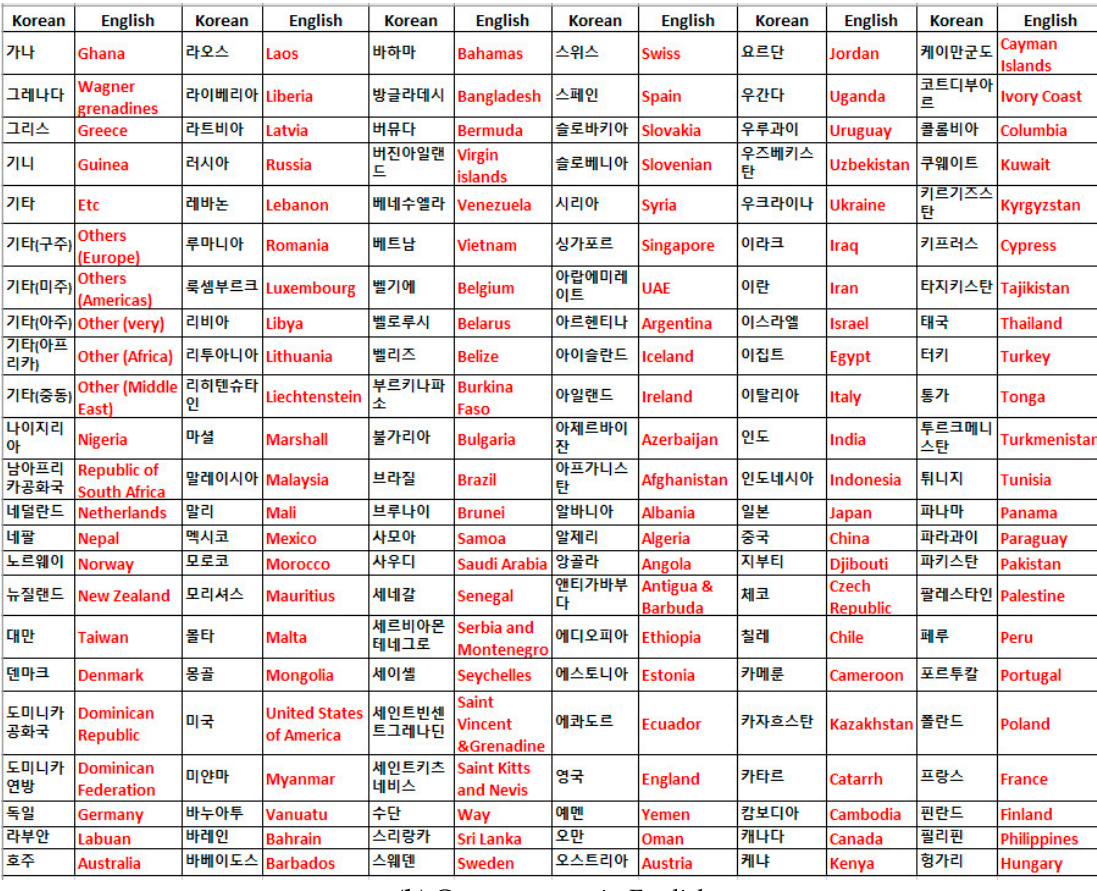
Figure 22. Data analysis of investment trends.